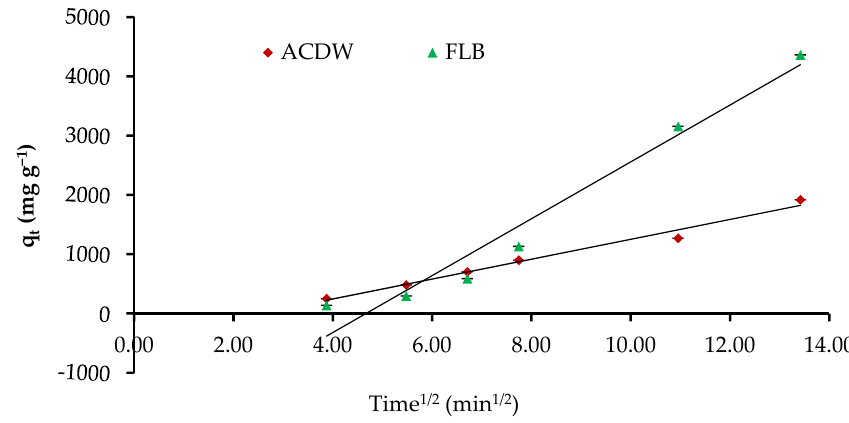
Figure 13. Intraparticle diffusion kinetics of IV2R dyes onto ACDB and LFB.